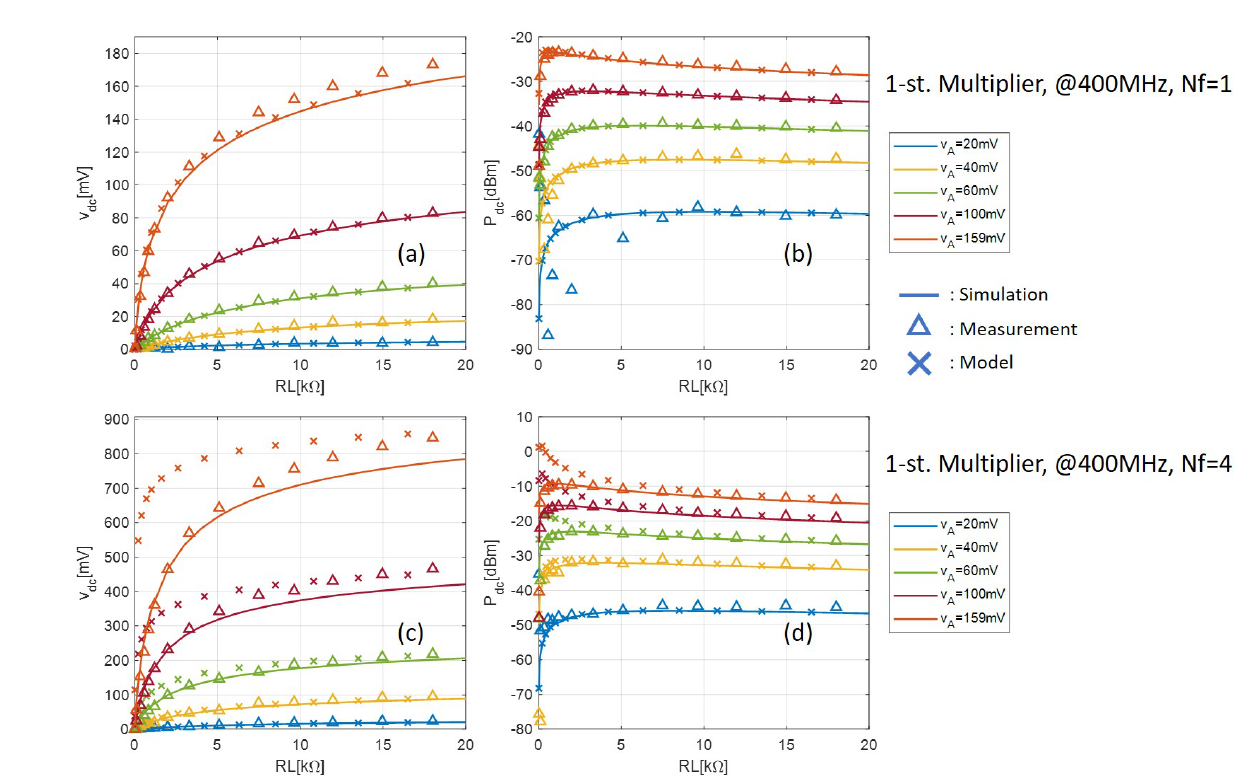
Figure 8. Comparison between measurement, simulation, and analytical model of the one-stage multiplier. Output DC voltage with ( a ) N f = 1 and ( c ) N f = 4; output DC power with ( b ) N f = 1 and ( d ) N f =